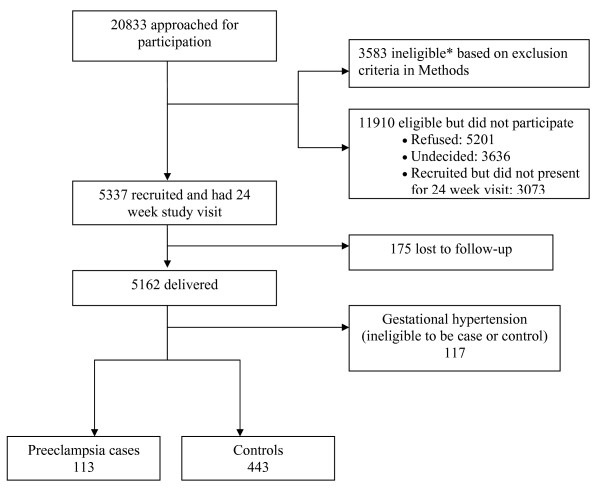
Study flow diagram. * data on reasons for ineligibility were available in 952. The most common reasons were lack of fluency in French or English (n = 321), plans to deliver in a non-study hospital (n = 272), severe chronic disease (n = 90) and gestational age at initial contact > 24 weeks (n = 62).